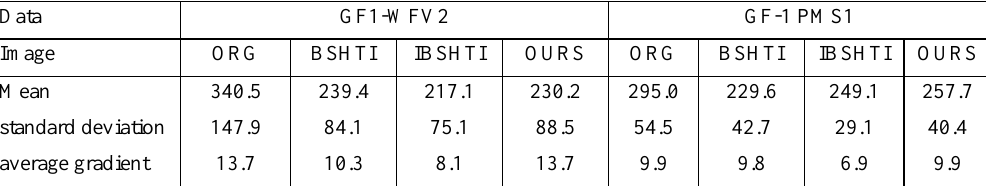
Table 3 Quantitative parameters of GF1-WFV2 and GF-1 PMS1 images